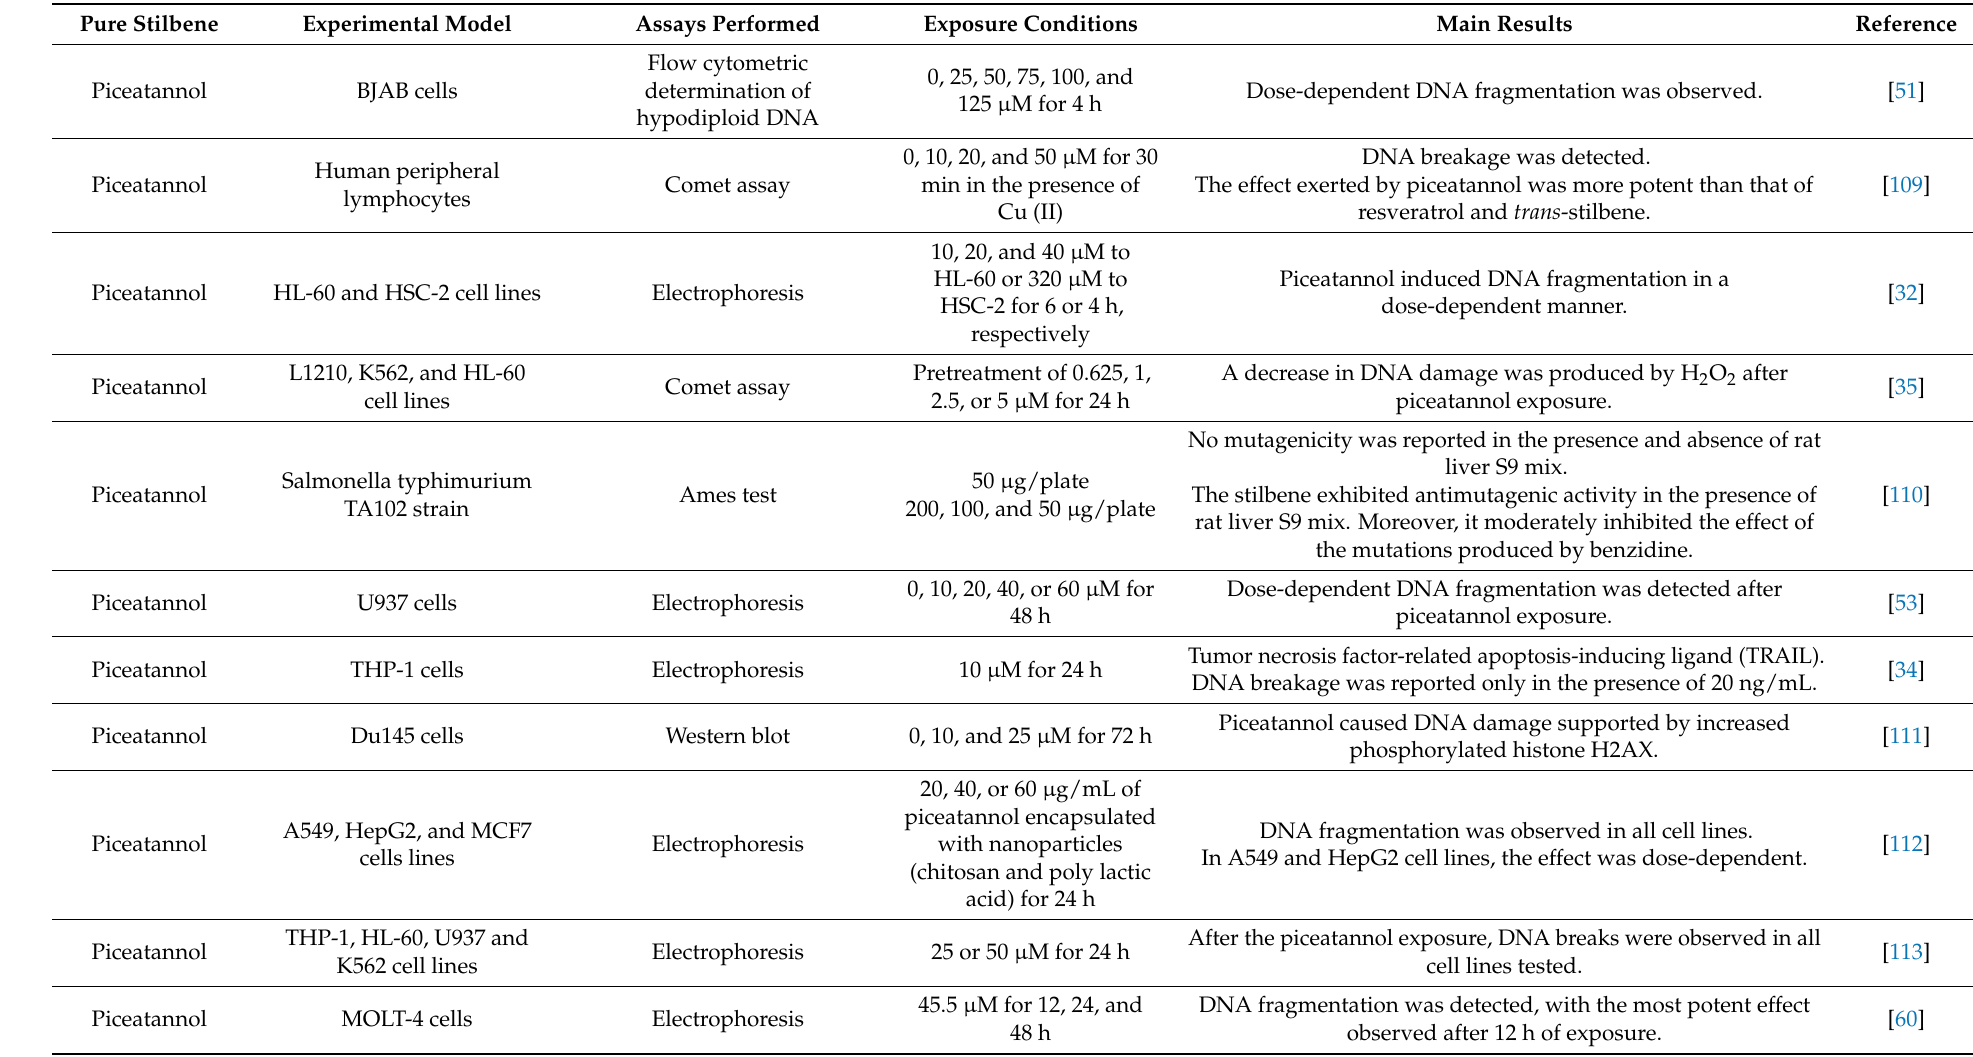
Table 7. In vitro genotoxicity and DNA damage studies performed with piceatannol, pterostilbene and ε